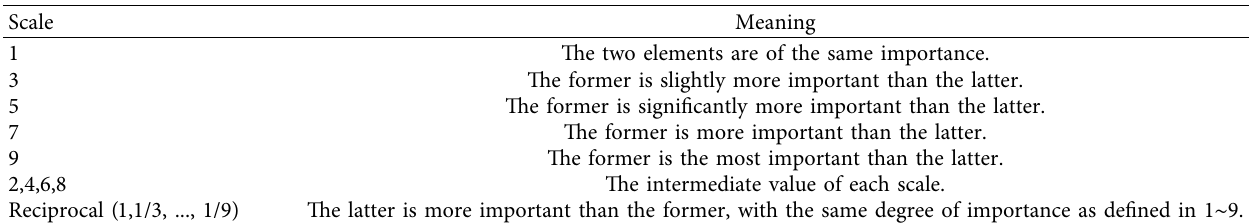
Figure 5: The network relationship diagram in ANP model. Table 2: 1 ∼ 9 scale scoring